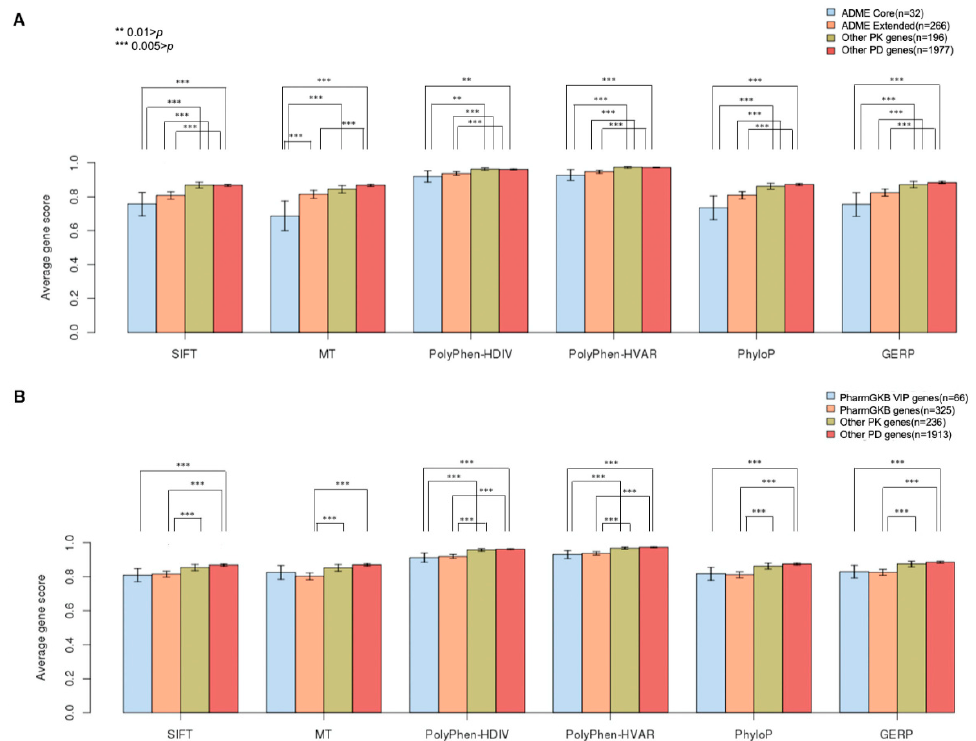
Figure 2. Gene-level GVB distribution in four pharmacogenetic categories across six in silico methods obtained from the 2504 individual genomes. Average GVB distributions of ( A ) ADME Core, Extended, Other PK, and Other PD genes and ( B ) PharmGKB VIP, Genes with known SNPs which affect drug efficacy from PharmGKB, Other PK, and Other PD genes across six in silico variant scoring methods (i.e., SIFT, MutationTaster, PolyPhen-2, PolyPhen-2 HVAR, phyloP, and GERP ++ ). The ADME Core and the ADME Extended genes exhibited significantly lower GVBs than those in the Other PK/PD genes and the PharmGKB (VIP) genes, similarly, exhibited significantly lower GVBs than those in the Other PK/PD genes from DrugBank. *** p < 0.005; ** p < 0.01.